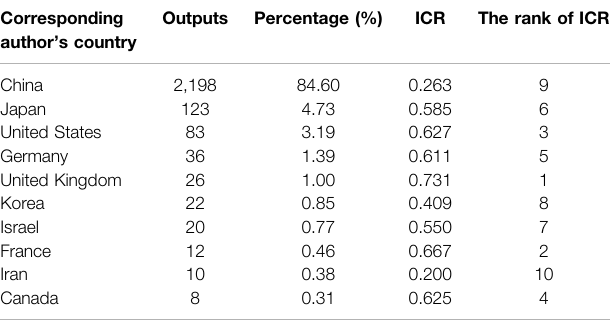
TABLE3| The10mostproductivecountriesandtheircorrespondinginternational cooperation rate (ICR), as measured by publications. Corresponding author ’ s country